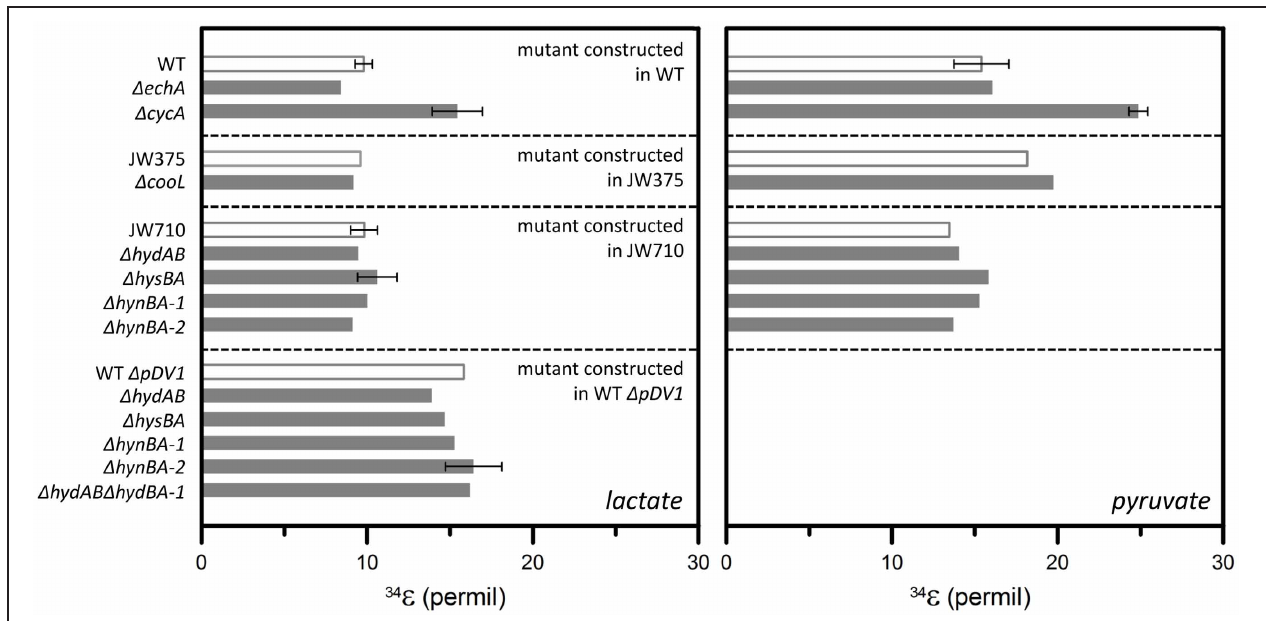
FIGURE 3 | Sulfur isotope effects produced by Desulfovibrio vulgaris Hildenborough and several mutants grown on lactate (left) and pyruvate (right). Mutants (gray bars) are grouped with their respective